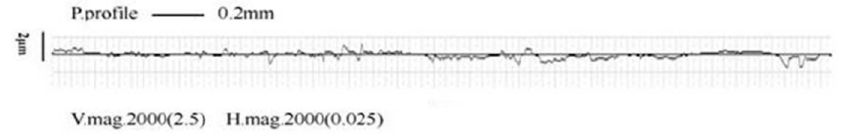
Figure 14. The surface profile of the electroplated Ni coating (80 kHz,100 W). The Ra is 0.16 μ m, 0.23 μ m and 0.36 μ m when the ultrasonic power is 0 W, 100 W and 200 W, respectively. The Ra is 0.23 μ m, 0.29 μ m and 0.41 μ m when the ultrasonic frequency